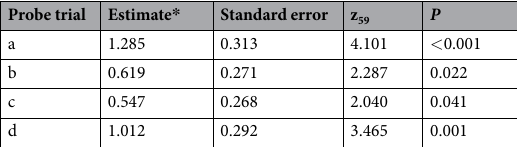
Table 2. Binomial models comparing performance in the four types of probe trials and the level of significance. a The same horizontal half of the face as in the standard trials but with novel faces; b: the other horizontal half of the same faces used in the standard trials; c: the other horizontal half of the novel faces; d: the left half (vertical) of the faces of the same persons used in the standard trials. * Coefficient estimate of binomial models with logit link, value of zero indicates a choice probability of